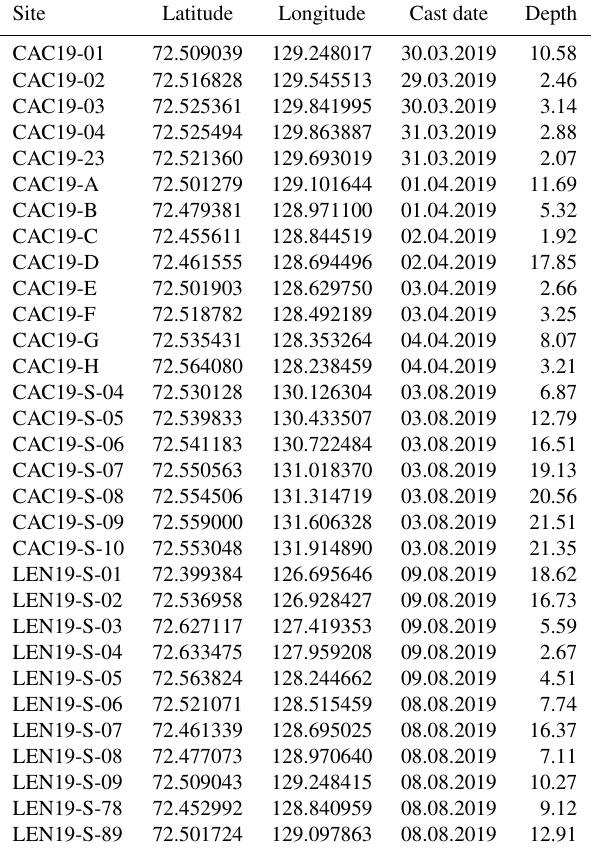
Table C1. Location and date of the CTD measurements in the Lena Delta region with the handheld SonTek TM CastAway